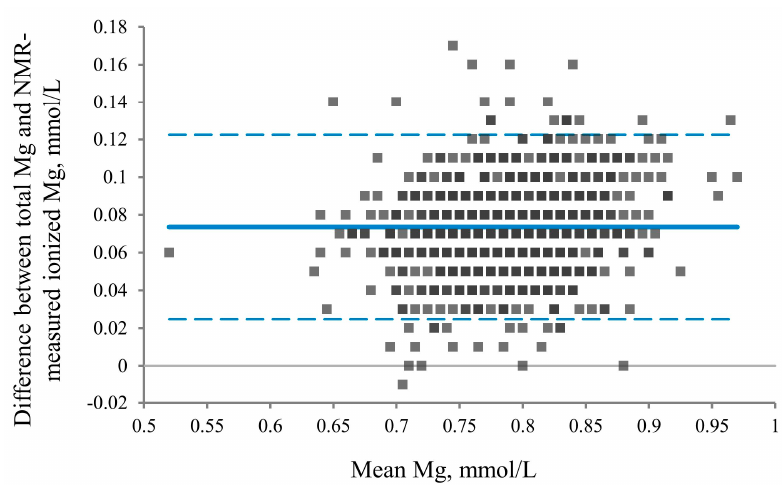
Figure 2. Bias plots for total Mg from the Roche Modular and nuclear magnetic resonance (NMR)-measured ionized Mg.